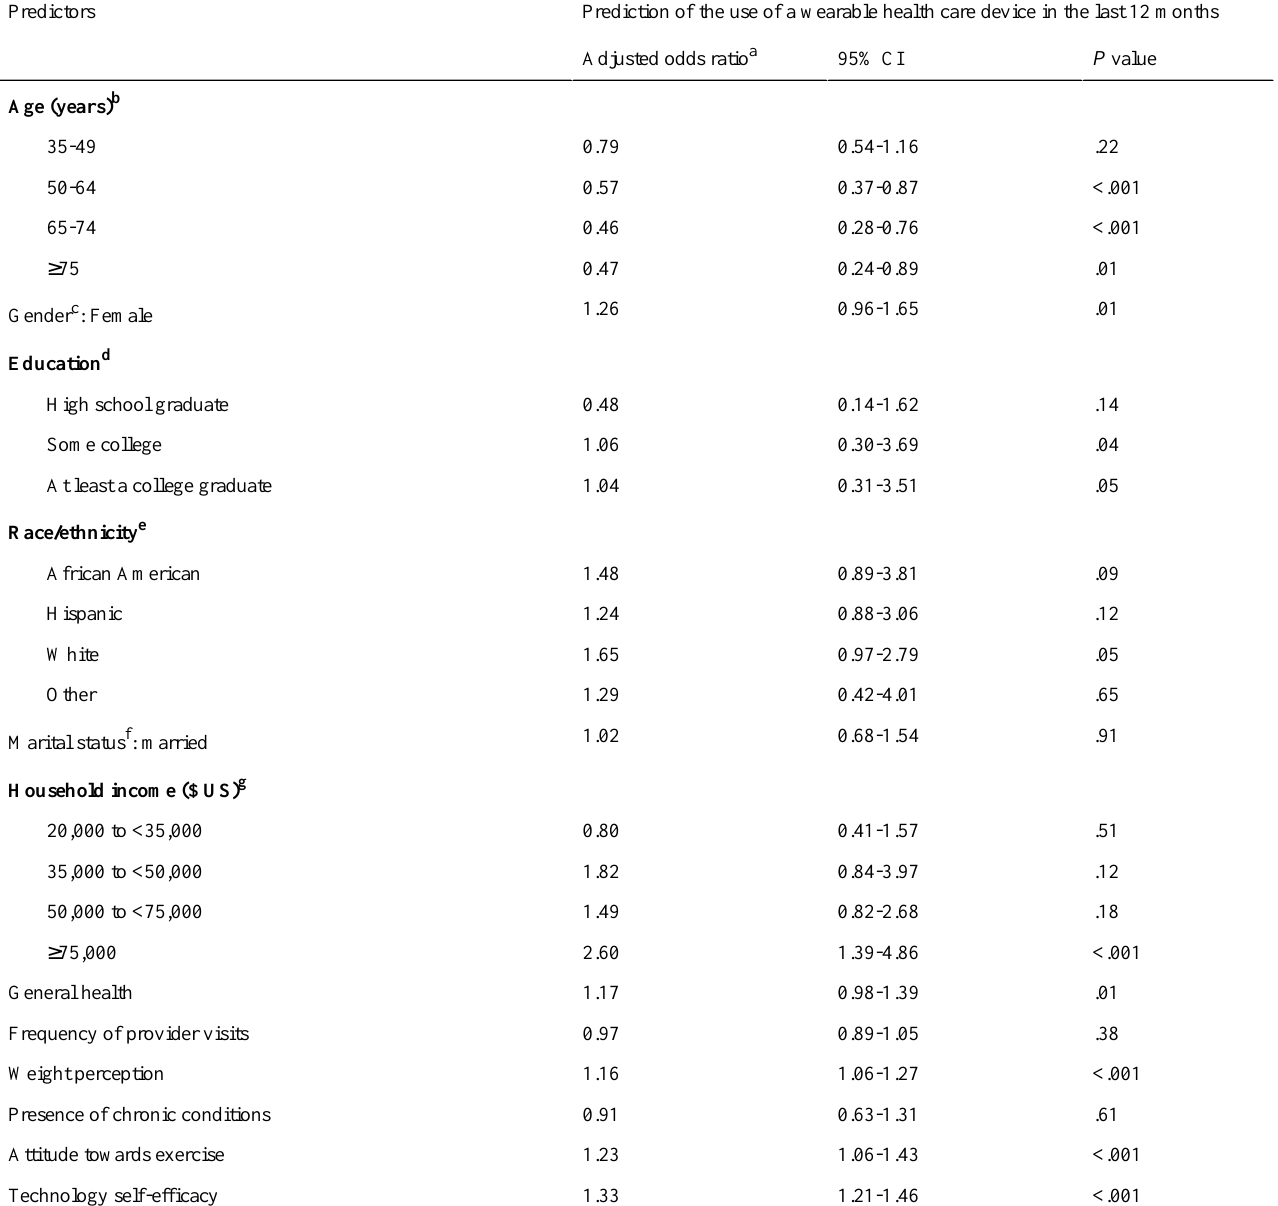
Table 2. The respondent characteristics that had the greatest influence in predicting the use of wearable health care devices.